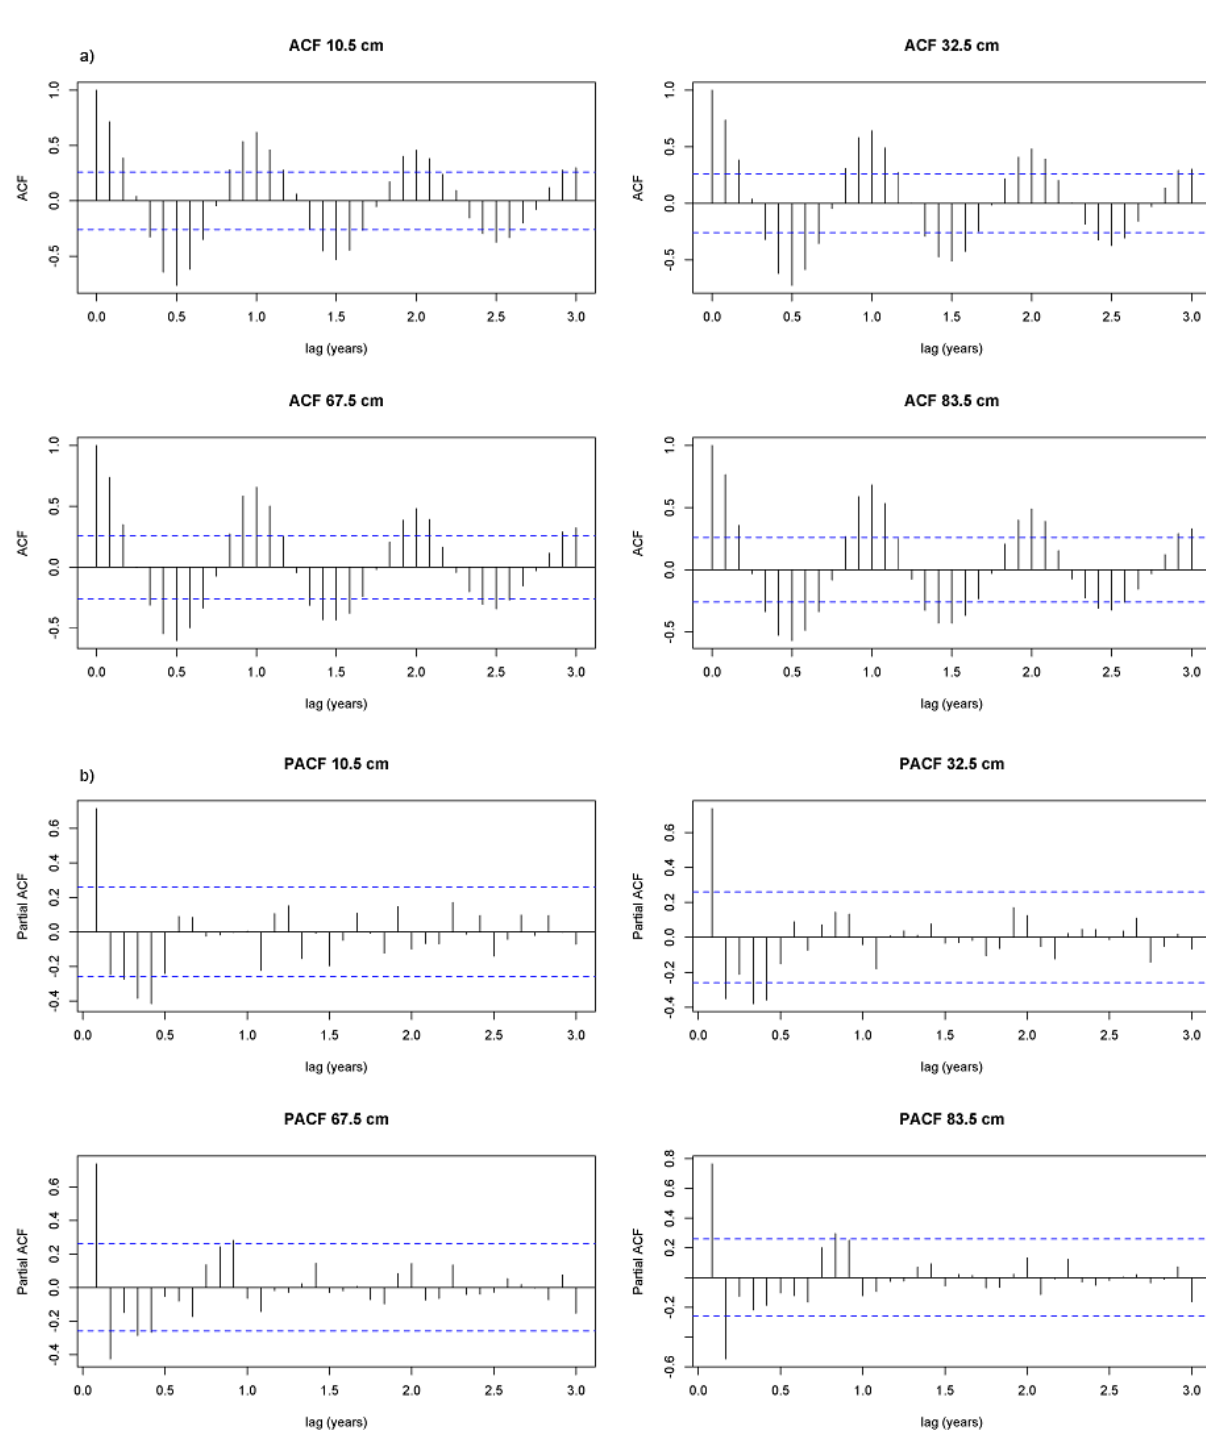
Figure 8. Autocorrelation and partial autocorrelation plots for F1, F2, F3 and F4.